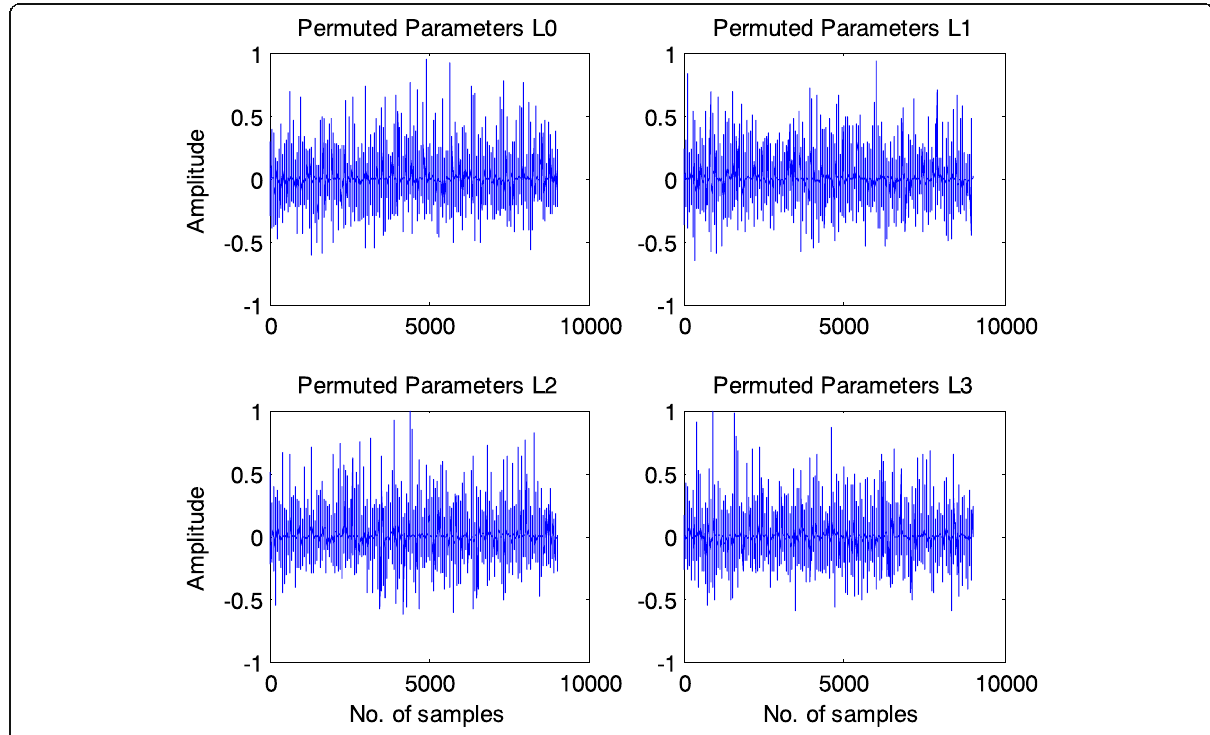
Fig. 6 Histogram of permuted and substituted parameters L 0 , L 1 , L 2 , and L 3